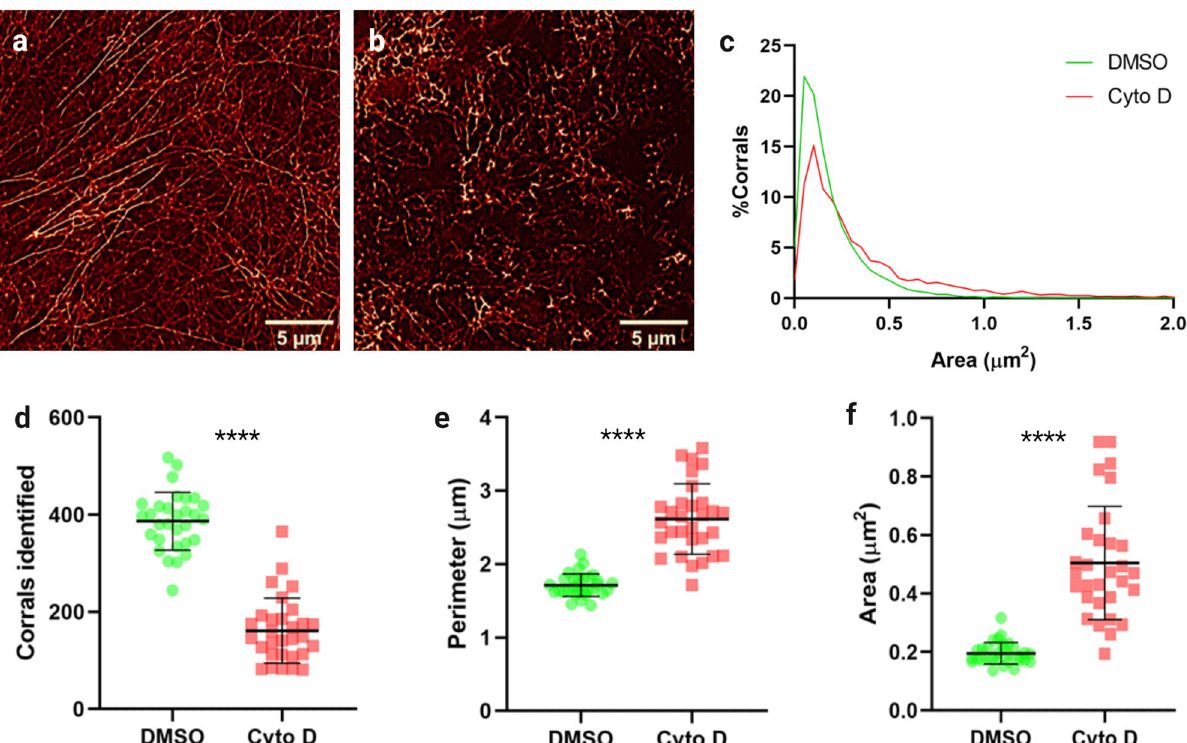
Figure 3. Treatment with cytochalasin D induces significant increase in corral sizes. ( a ) Representative SRRF image of phalloidin labelled actin in DMSO treated cells, and ( b ) cytochalasin D treated cells. ( c ) Histogram of all corral areas for cytochalasin D treated and control cells. ( d ) Number of corrals, ( e ) mean perimeter, and ( f ) mean area of corrals identified in cytochalasin D treated cells versus DMSO control. n = 3, 30 cells per treatment. **** p < 0.0001. All graphs show mean ± standard